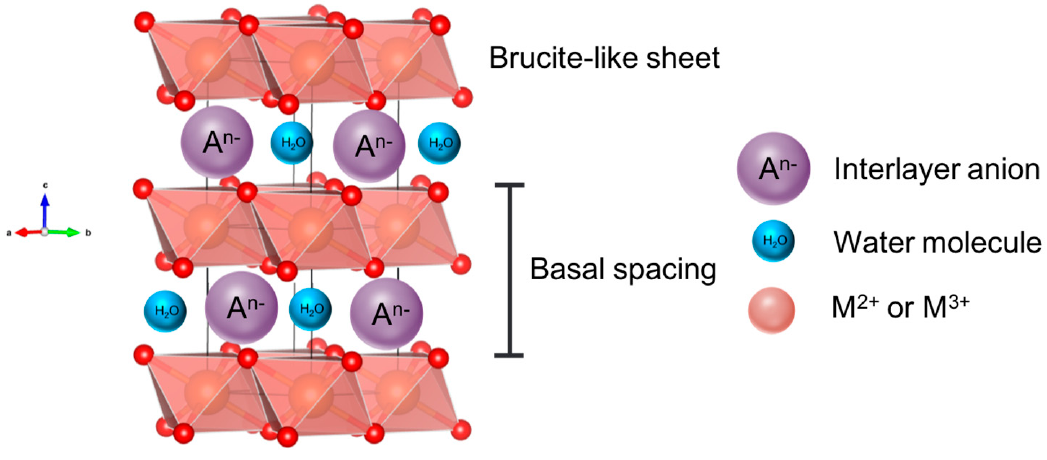
Figure 1. A schematic structure of layered double hydroxides.